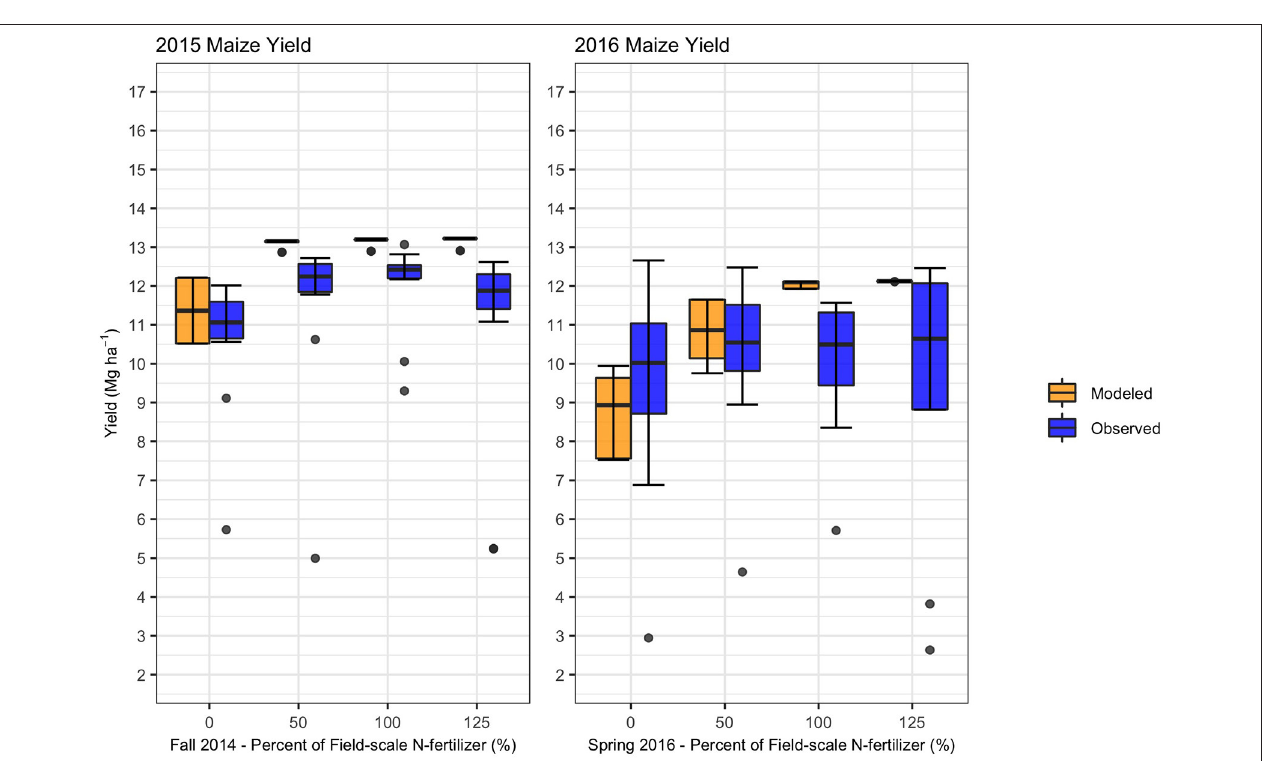
FIGURE 5 | Scatter plot of simulated and spatially averaged yield monitor data corresponding with each experimental N-treatment plot located in the northcentral Iowa field.